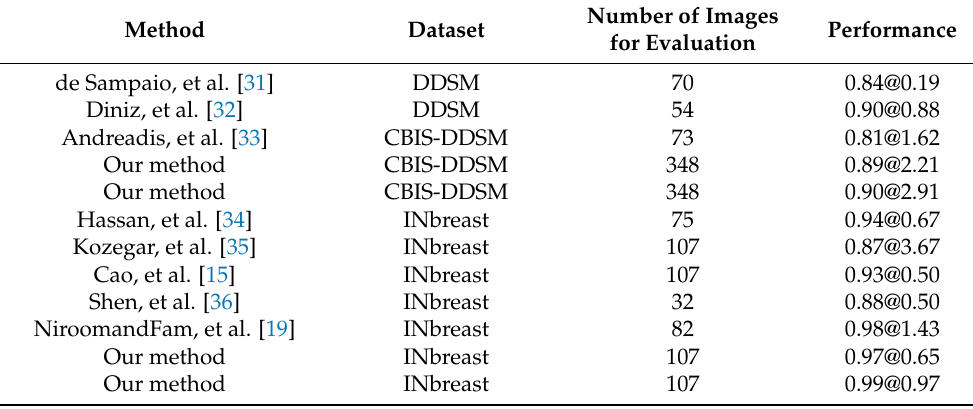
Table 13. Method